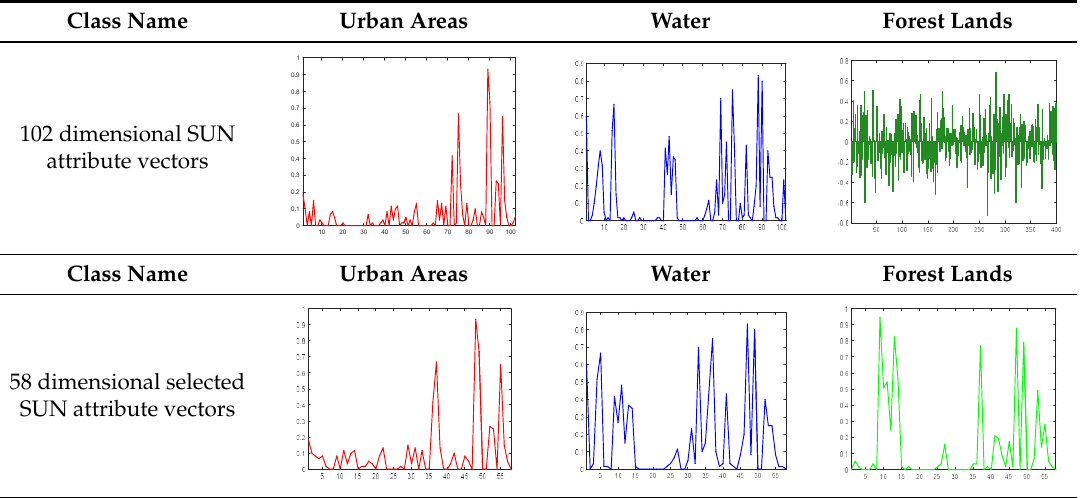
Table 2. The examples of the land cover class and corresponding SUN/selected SUN attribute vectors.